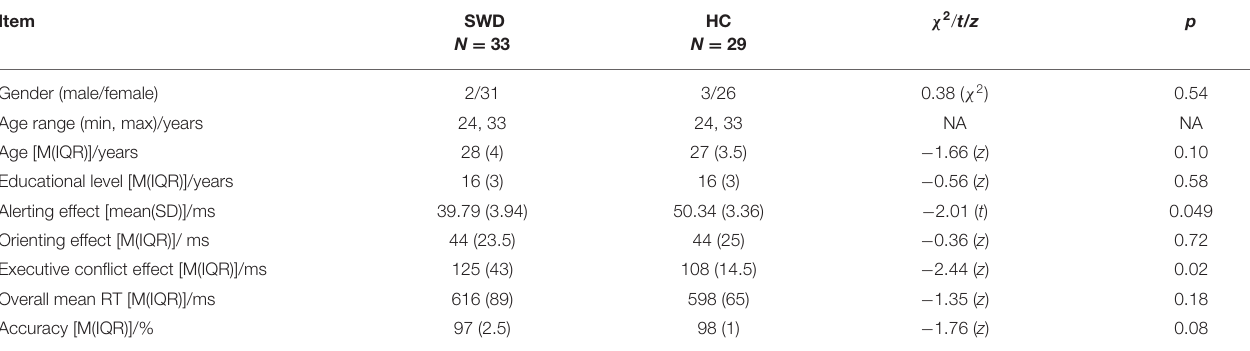
TABLE 1 | The demographic information and ANT between patients with SWD and healthy controls.